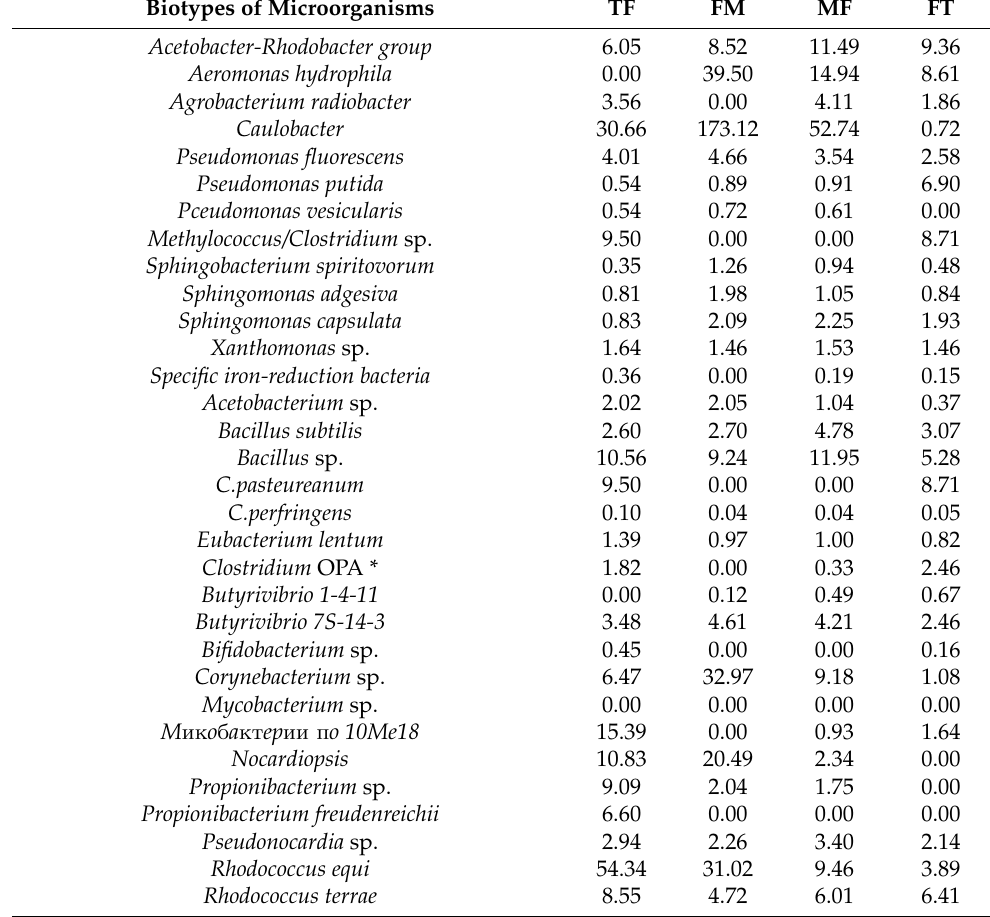
Table 2. The number of the most important microorganisms in the soils of the high-altitude gradient of Mount Kivakka of Eastern Fennoscandia (cells/g × 10 6